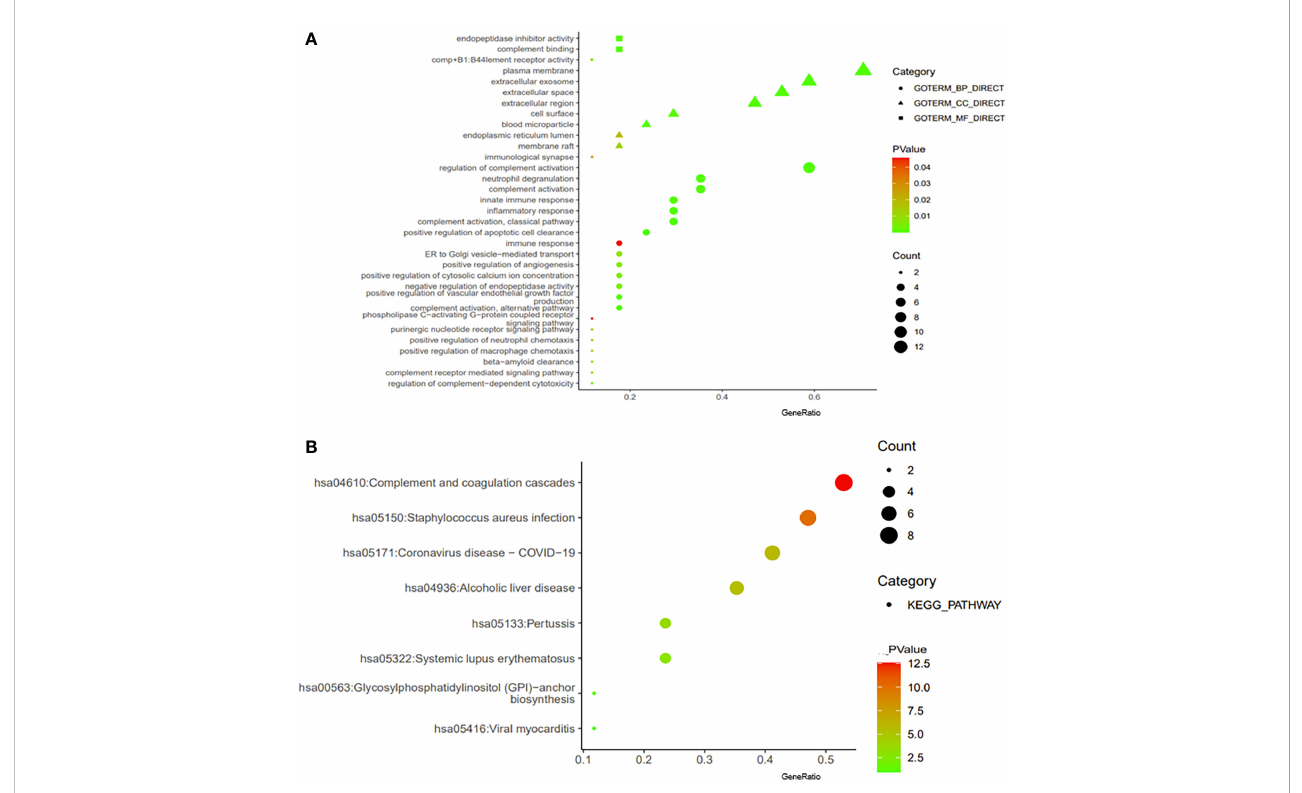
FIGURE 7 Enrichment analysis of CD55 . The visualization of GO enrichment analysis (A) and KEGG enrichment analysis (B) of CD55 by DAVID 6.8. GO, Gene Ontology; KEGG, Kyoto Encyclopedia of Genes and